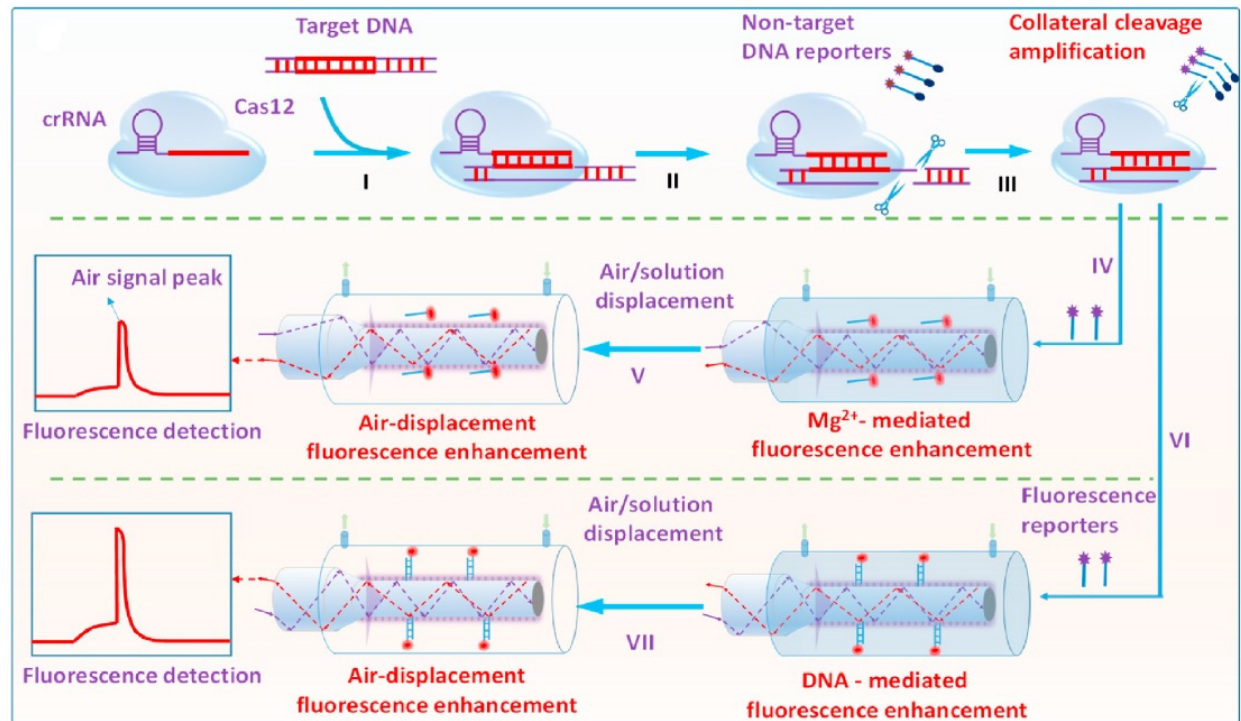
Figure 17. A CRISPR/Cas12a-powered FOEW sensor for nucleic acid amplification-free detection of Staphylococcus aureus with multiple signal enhancements. Reprinted from Song et al. (2023) [120], Copyright (2023), with permission from Elsevier.